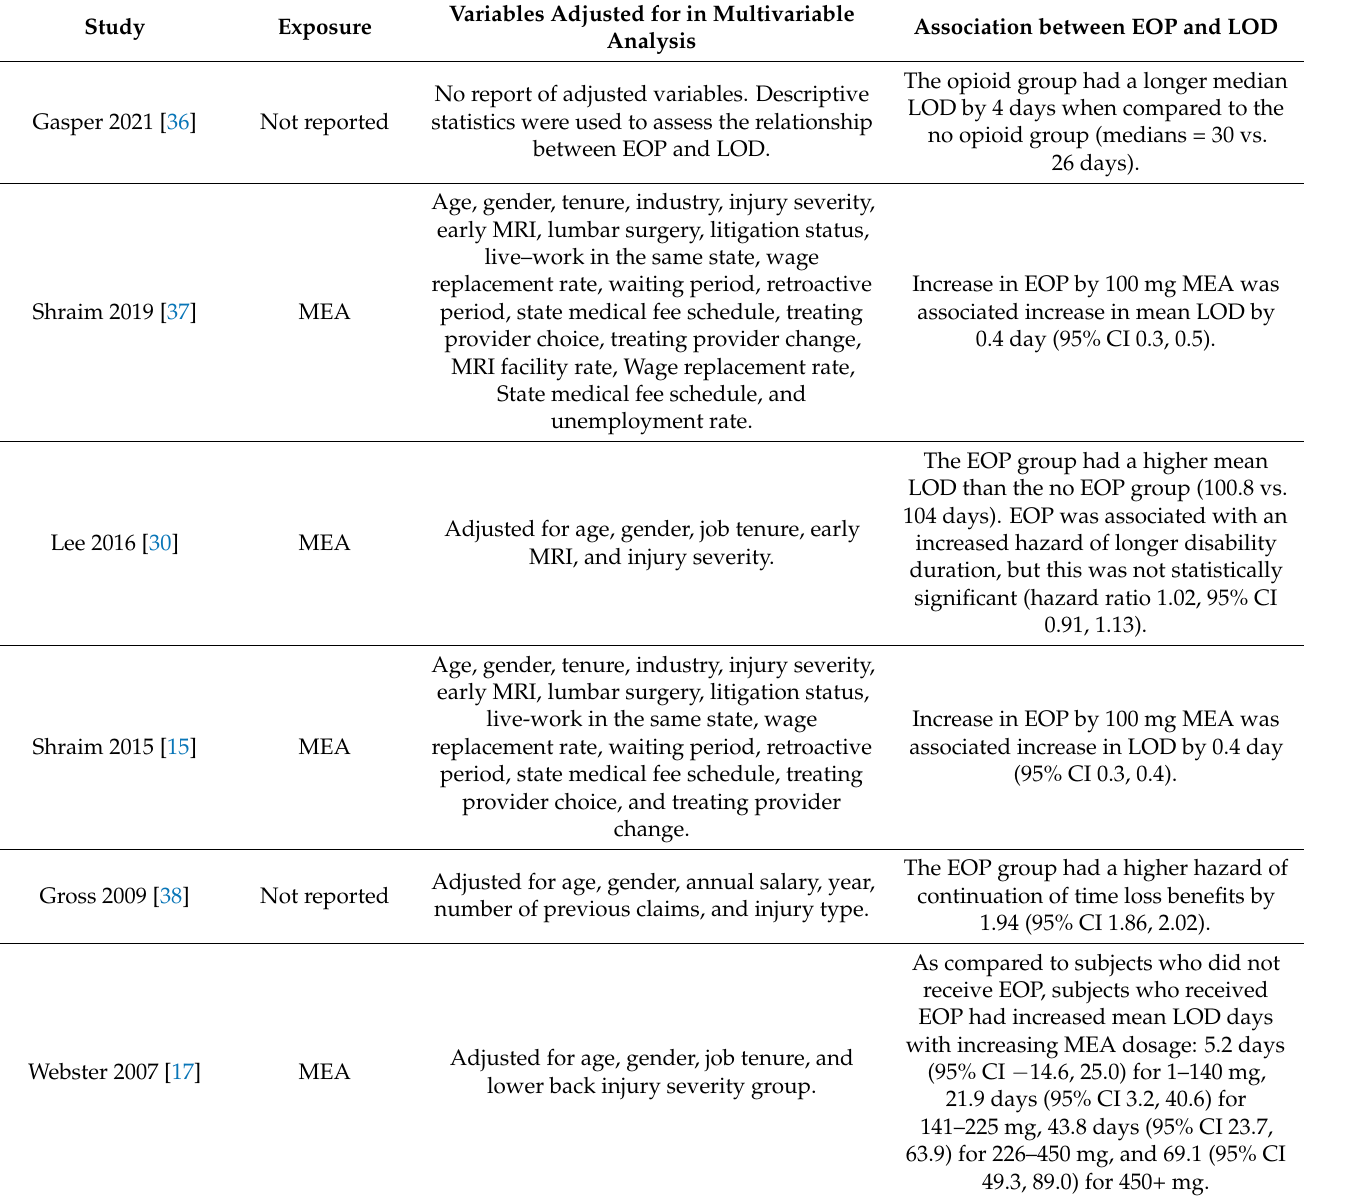
Table 3. The relationship between EOP and length of